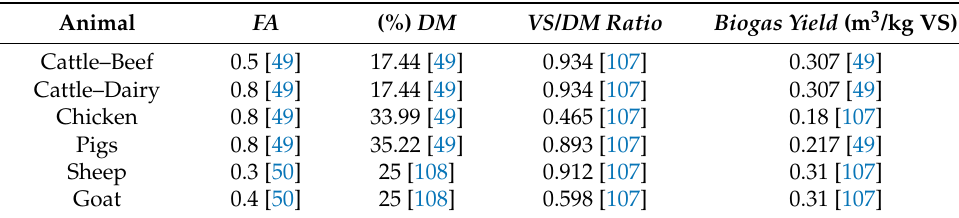
Table A4. Source(s) and data used for the calculation of the EP from livestock waste.